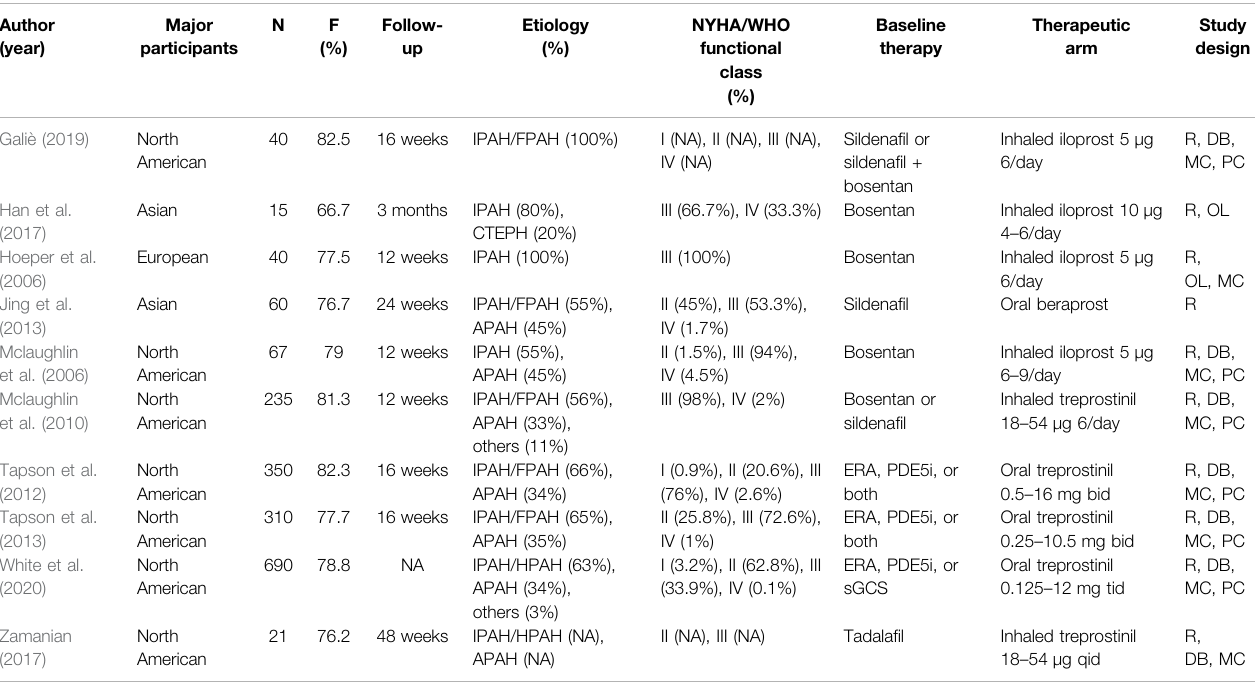
TABLE 1 | Basic characteristics of included